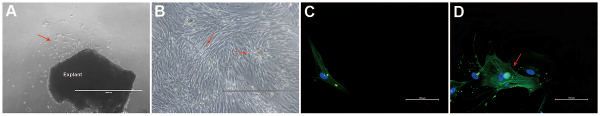
The morphologies and immunofluorescence analysis of VMSCs cultured from human plaque. (A) Cells starting to grow out radially from the explants within 7 to 12 days (red arrows). (B) Cells growing into cells and showing typical “hills and valleys” morphology in about 4 weeks. Larger “hills” form into nodules (red arrows); (C) α SMA expression in human plaque-derived VSMCs with a fusiform shape; cytoplasm (green), nucleus location (blue). (D) Uniform filamentous of α-SMA (red arrows) can be observed universally in human plaque-derived VSMCs with a big, flattened shape.